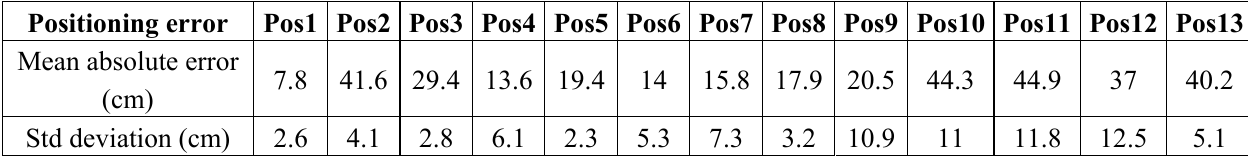
Table 2. Positioning error for the different positions